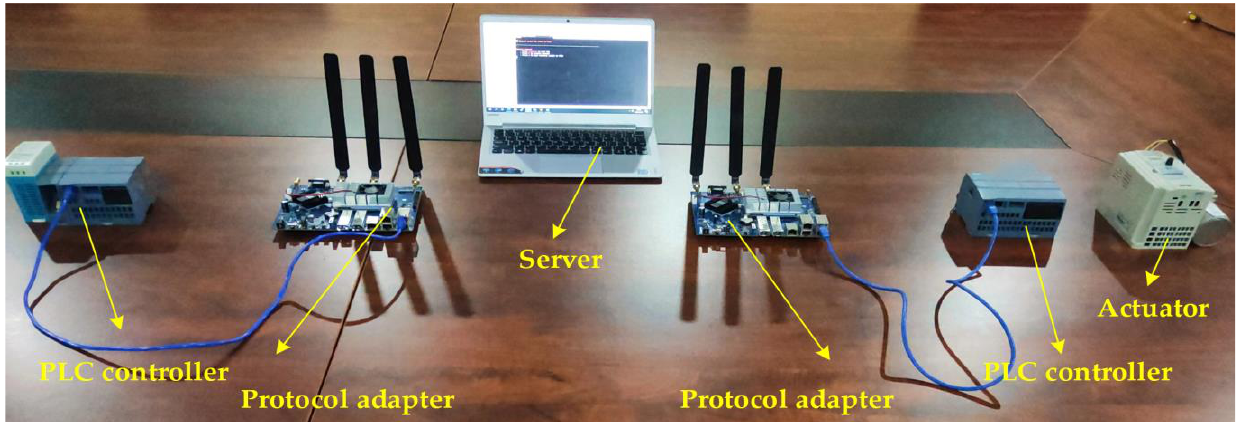
Figure 11. The internal connection of the wireless PLC prototype for Modbus TCP.